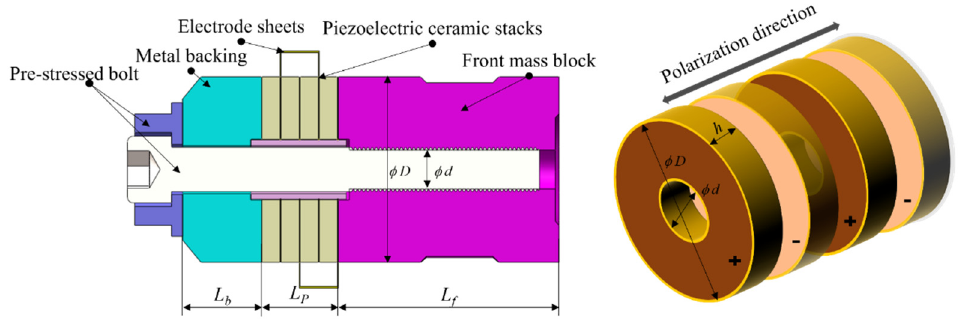
Figure 1. Schematic diagram of the structure of the sandwich piezoelectric